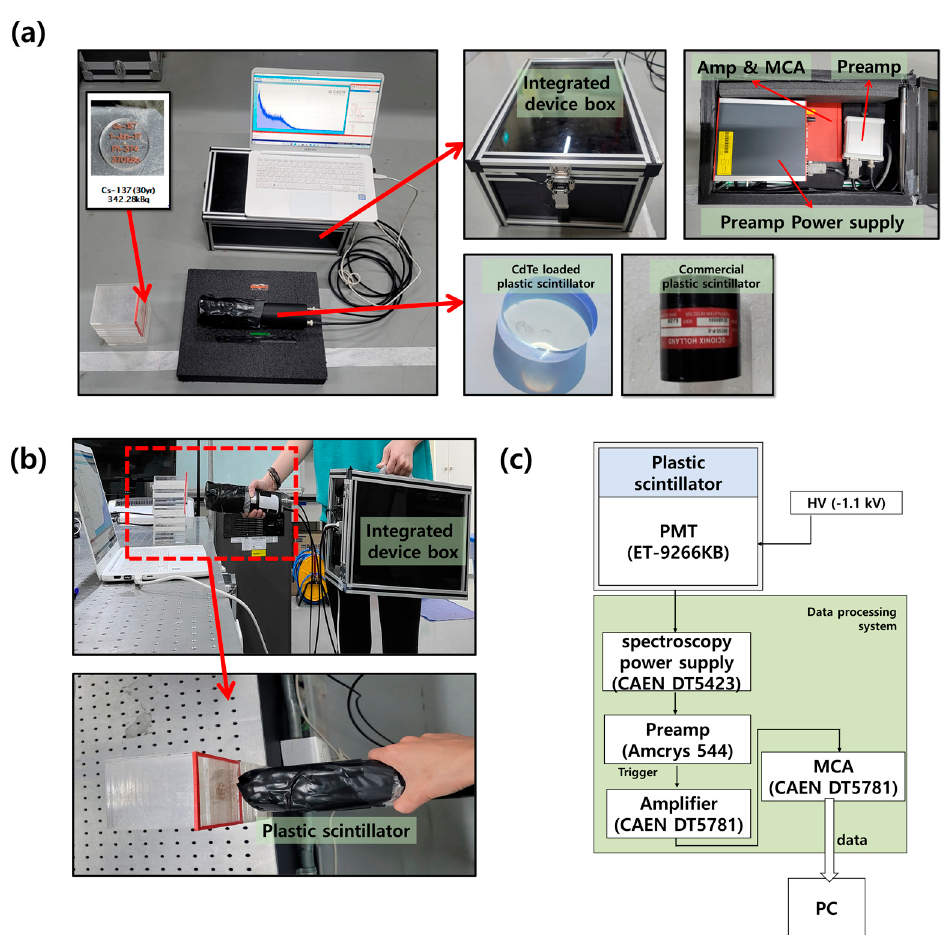
Figure 5. ( a ) Real picture of the performance experimental setup for gamma energy spectrum using a functional plastic scintillator. ( b ) Real picture of integrated device box and portable probe with a functional scintillator. ( c ) Schematic illustration for plastic detection system.